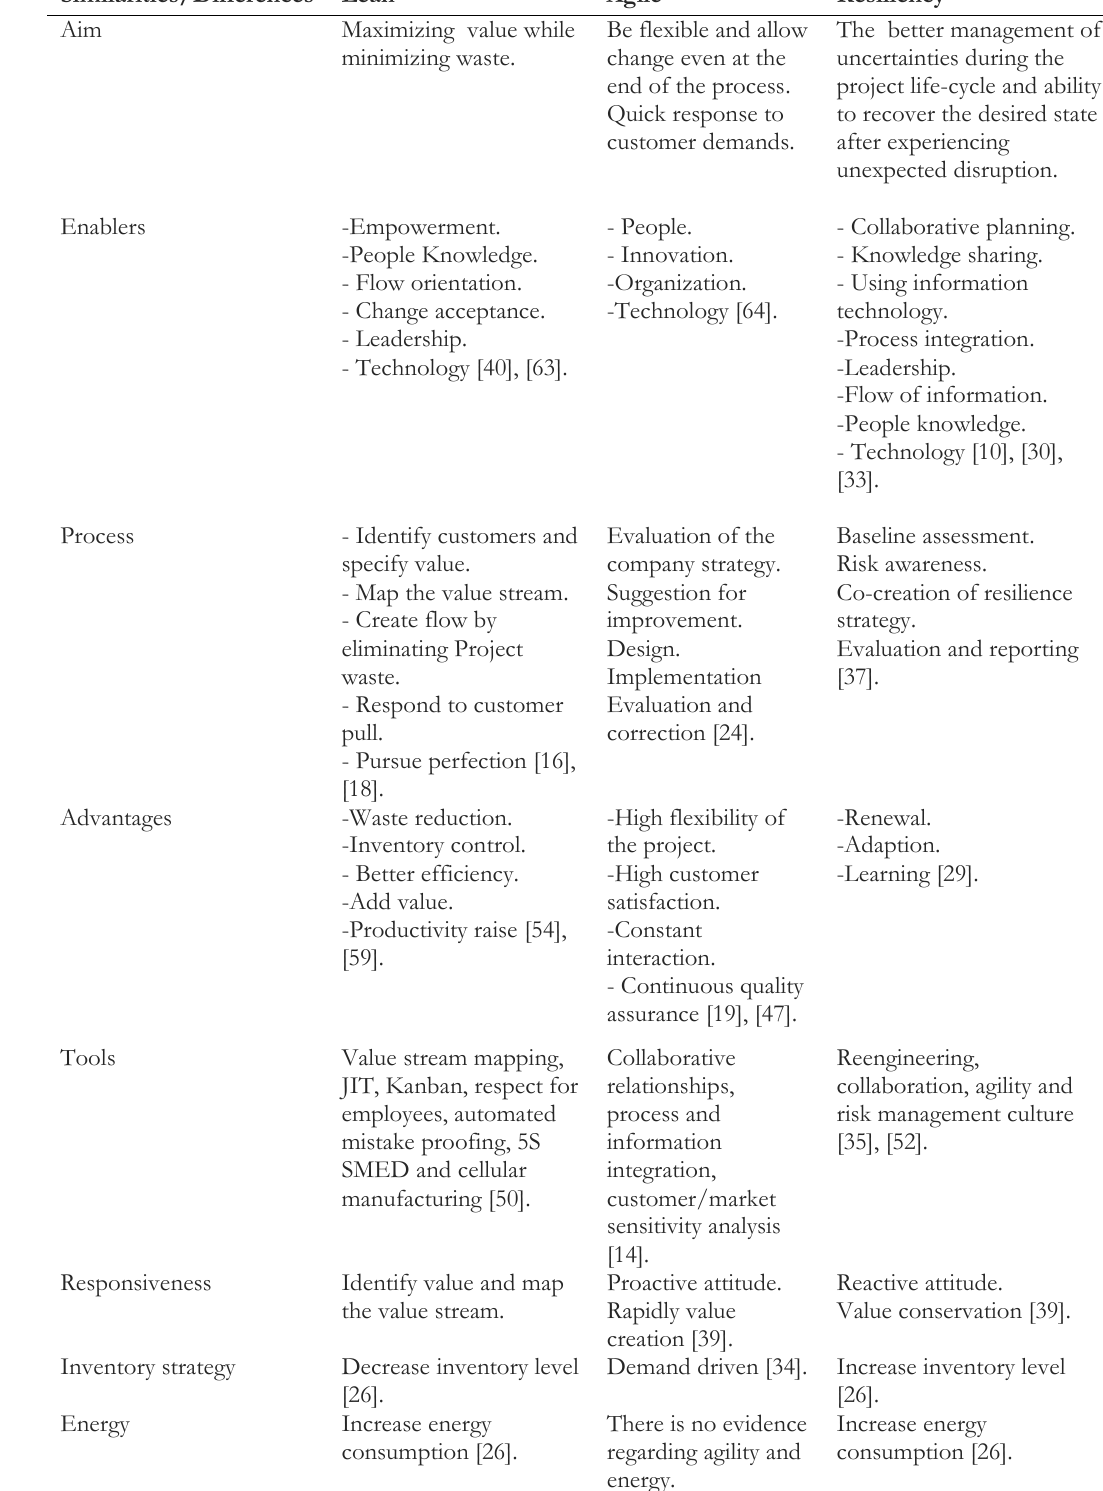
Table 2. Comparision between lean, agile and